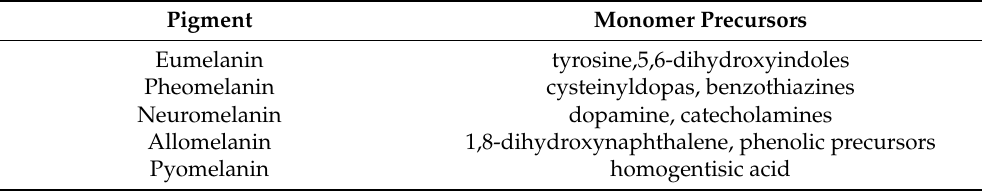
Table 1. The five major melanins and their precursors. Adapted from [43] with minor modifications.